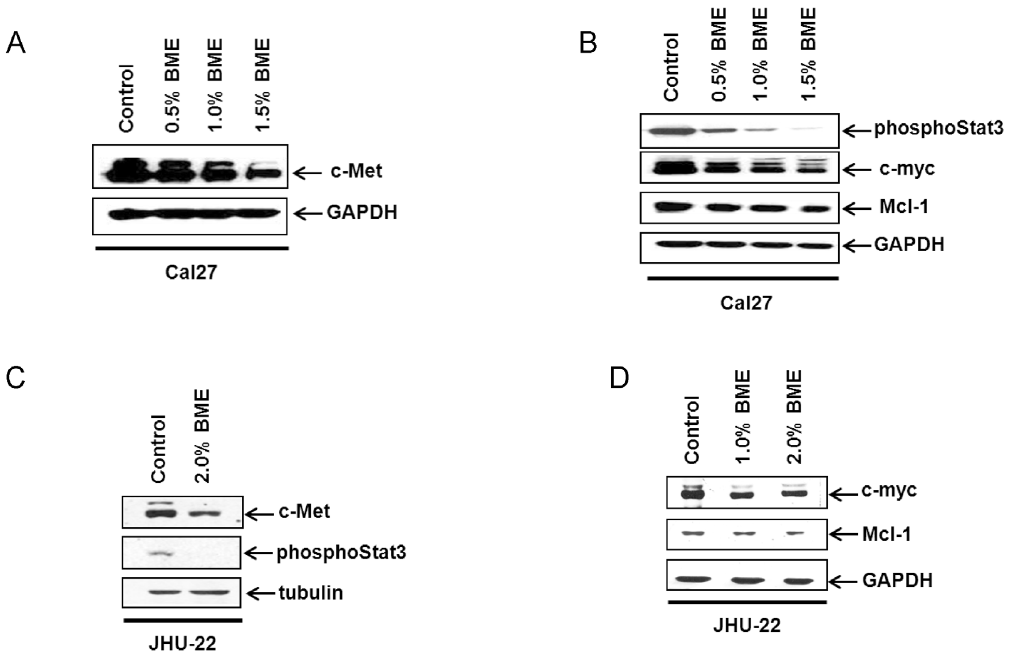
Figure 3. Treatment of BME in HNSCC cells decreases c-Met protein expression and its downstream signaling pathways. (A). Cal27 cells were treated with BME in a dose dependent manner and reduced c-Met expression was noted by Western blot analysis. The blot was reprobed with an antibody to GAPDH for comparison of equal protein load. (B). The expression levels of phosphoStat3 (Tyr705), c-myc and Mcl-1 in control and BME treated Cal27 cells were examined by Western blot using specific antibodies. The blot was reprobed with an antibody to GAPDH for comparison of protein load. (C). JHU-22 cells were treated with BME for 48 h and cell lysates were analyzed for c-Met and phosphoStat3 expression by Western blot analysis using specific antibody. The blot was reprobed with an antibody to tubulin for comparison of protein load. (D). The expression levels of c-myc and Mcl-1 in control and BME treated JHU-22 cells were examined by Western blot using specific antibodies. The blot was reprobed with an antibody to GAPDH for comparison of protein